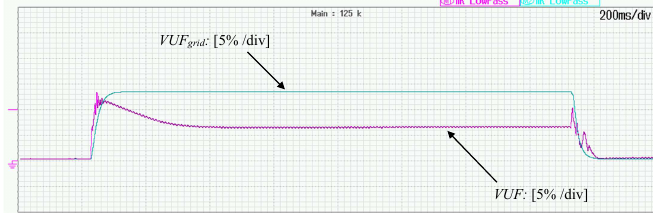
Figure 9. Operation under two-phase voltage drop ( V ga = 0.73p.u. and V gc = 0.65p.u.): Injected powers.